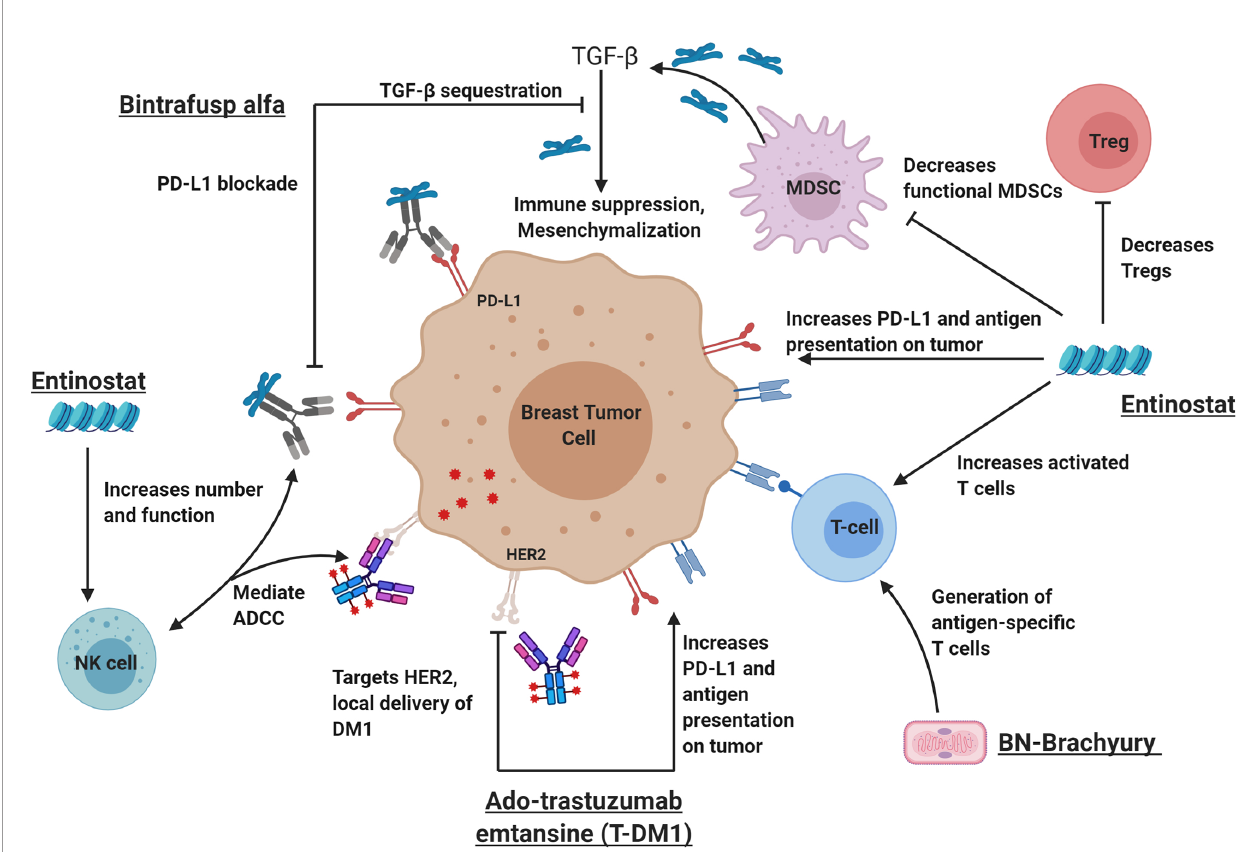
FIGURE 1 | The rational combination of immunotherapy agents can augment key components of a successful anti-tumor immune response. From left to right: Bintrafusp alfa inhibits PD-L1 and sequesters TGF- b in the tumor microenvironment leading to activation of immune effector cells (including natural killer cells) and decreased tumor plasticity. Ado-trastuzumab emtansine (aka T-DM1I, Kadcyla) is an antibody drug conjugate that targets the HER2 receptor and allows the delivery of the anti-microtubule chemotherapy called DM1. Like other HER2-targeting antibodies, T-DM1 also mediates ADCC, increases antigen presentation on tumor cells and increases PD-L1 expression on the tumor and immune cells. BN-Brachyury vaccines generate brachyury-speci fi c T cell responses in breast cancer. Brachyury is a transcription factor involved in tumor plasticity, metastasis, chemoresistance, and poor clinical outcomes in breast cancers. Entinostat is an HDACi that increases antigen presentation, increases activated T cells and decreases Tregs. In addition, entinostat is also known to decrease HER2 resistance through various mechanisms. It is hypothesized that this tetratherapy will induce a robust immune response against breast cancer with improved tumor control. ADCC, antibody- dependent cell-mediated cytotoxicity; HDACi, histone deacetylase inhibitor; MDSCs, myeloid-derived suppressor cells; NK cell, natural killer cell; PD-L1, programmed death-ligand 1; TGF- b , transforming growth factor beta. This fi gure was created by MG-M using